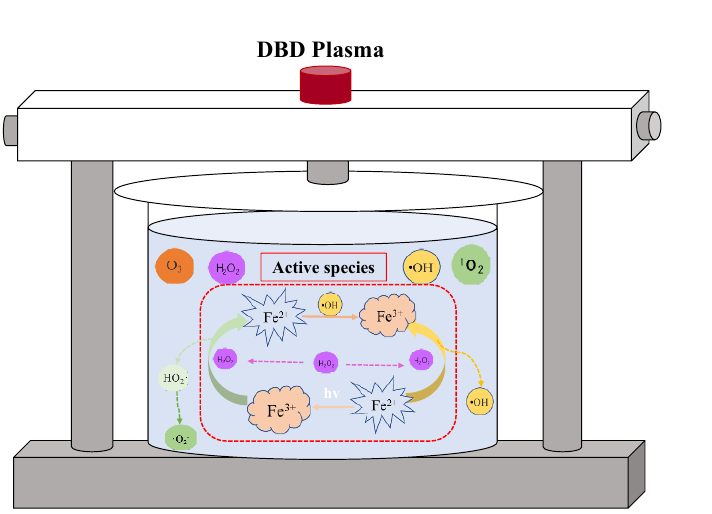
Figure 7. Mechanism of DBD coupled with a Fenton catalyst for the degradation of organic pollu-